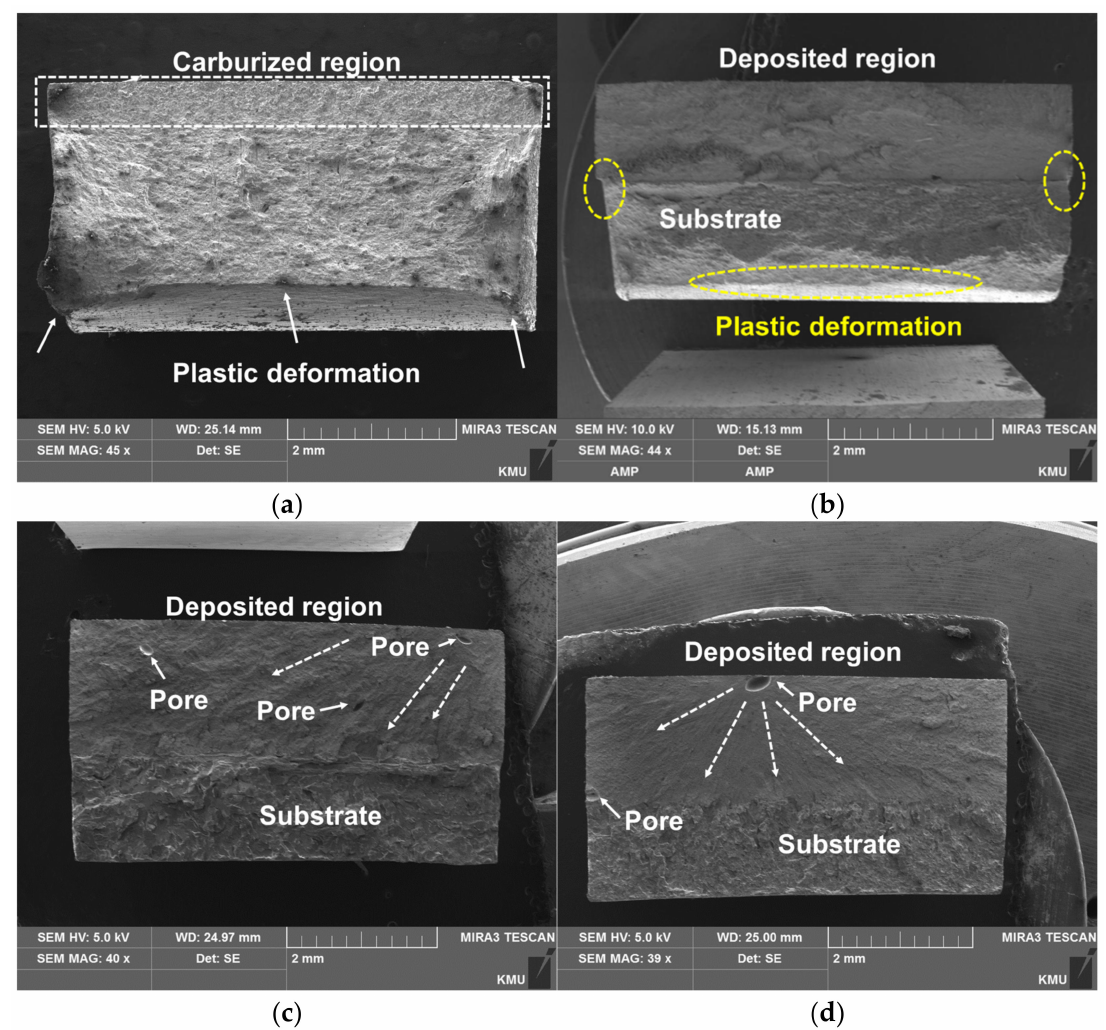
Figure 16. Fracture surfaces of the tensile specimens: ( a ) C-SCM420, ( b ) as-built (M2), ( c ) as-built (FeCrVMoW) and ( d ) as-built